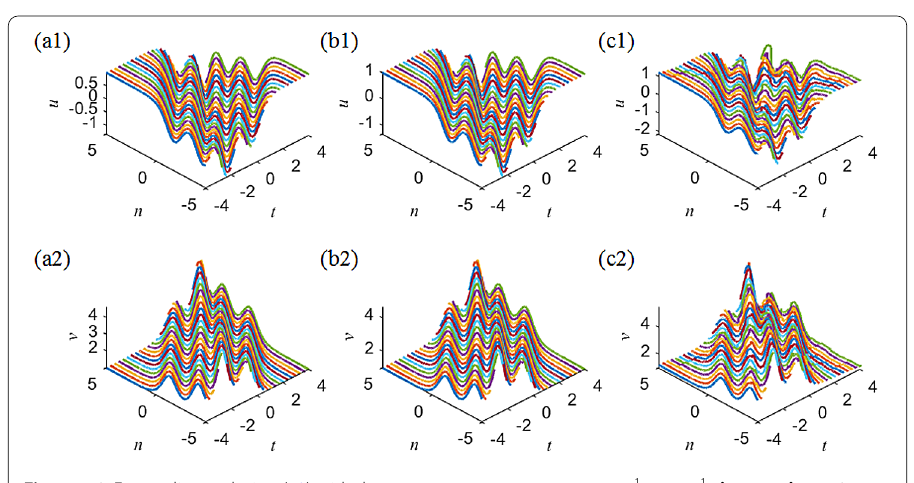
Figure 16 Four-soliton solution (52) with the parameters r 1 = 1, r 2 = –1, r 3 = 1 λ 3 = –2.5, λ 4 = –2 when N = 2. ( a ) Exact solution; ( b ) Time evolution using exact solution (52) as an initial condition; ( c ) Time evolution using exact solution (52) perturbed by a 20% noise as the initial condition